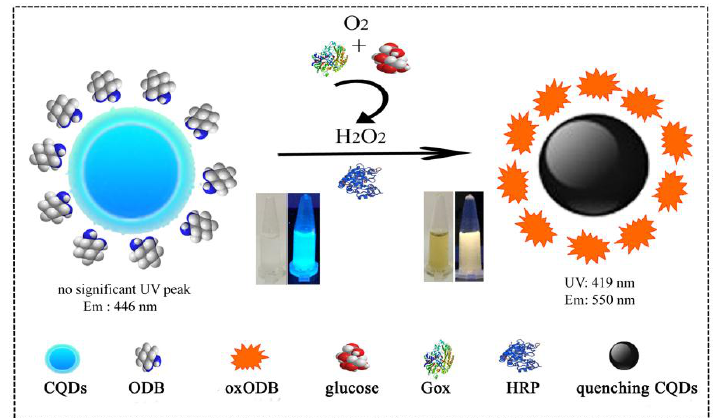
Figure 1. The detection principle of a dual-mode glucose sensor based on carbon quantum dots (CQDs) and o-diaminobenzene (ODB).